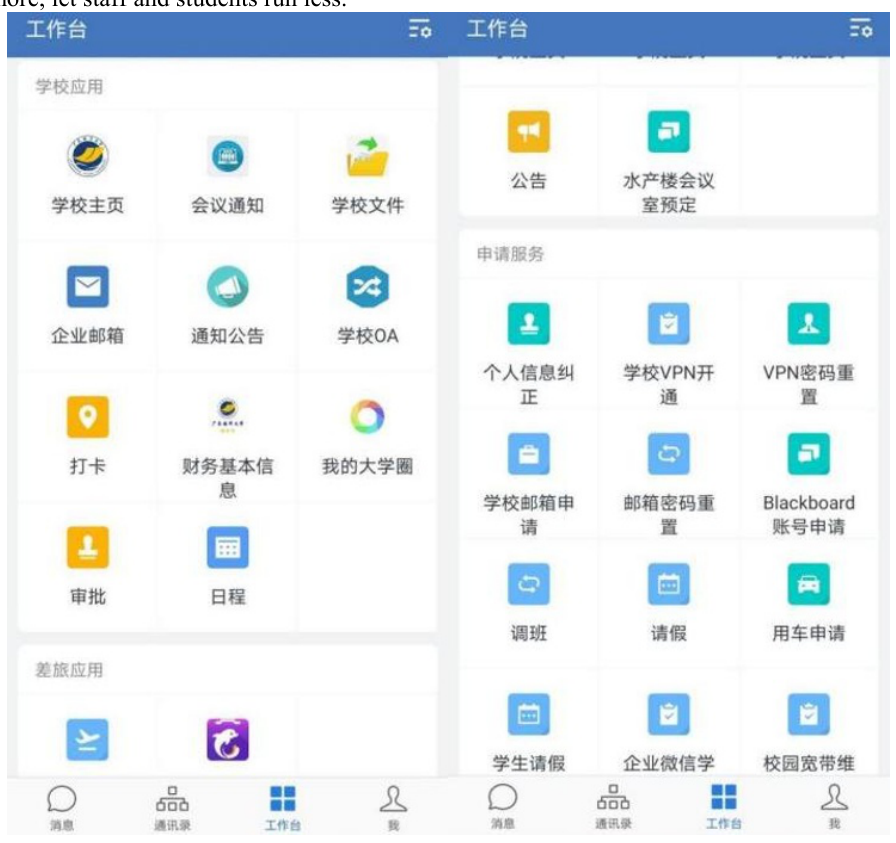
Fig. 3. Workbench of Faculty Mobile Service